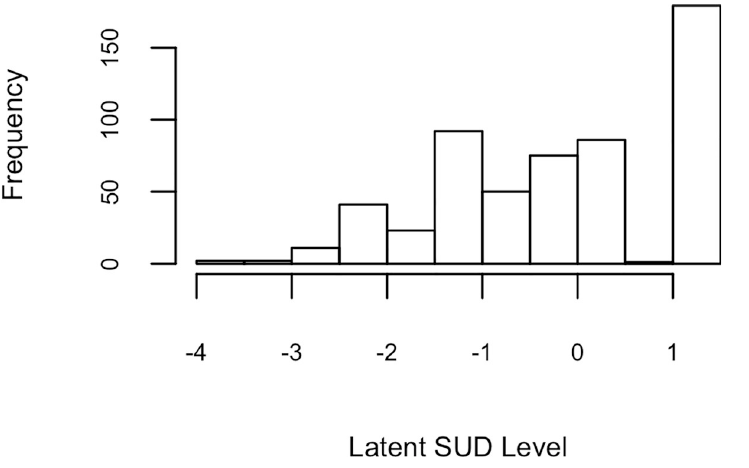
Fig 1. Histogram of participants’ latent scale score of SUD by the Rasch